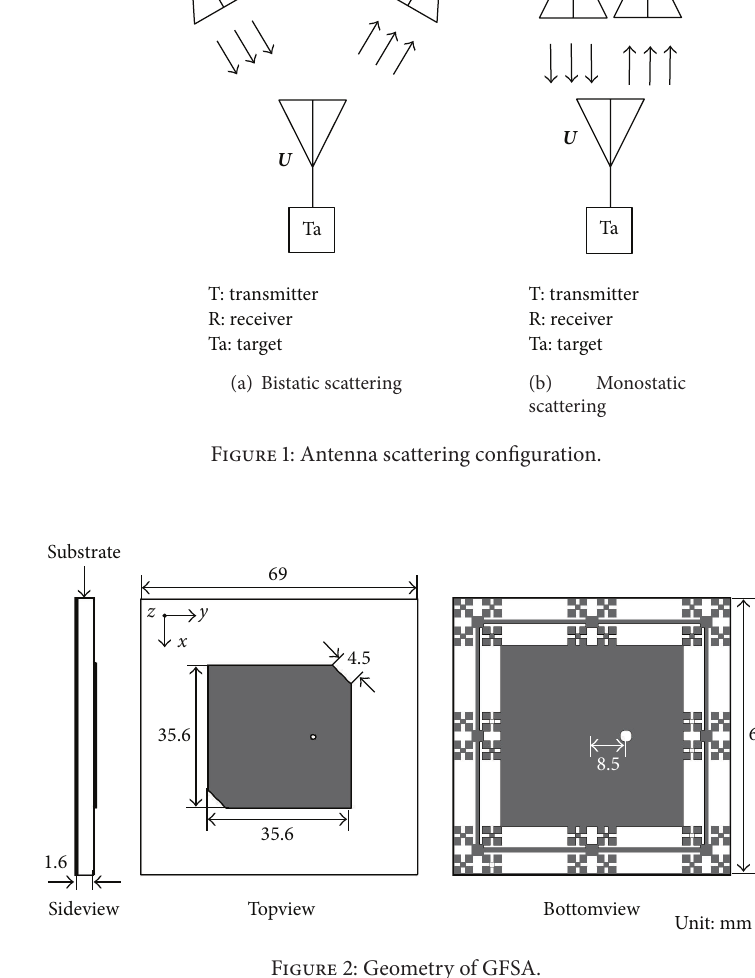
Figure 2: Geometry of